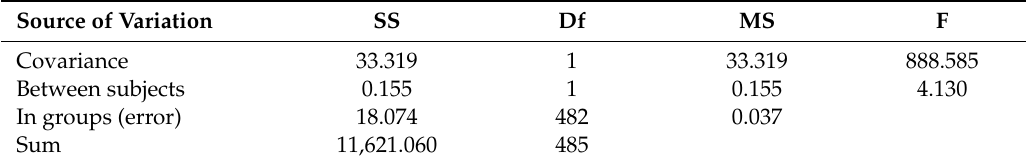
Table 8. Right eye visual acuity ANCOVA